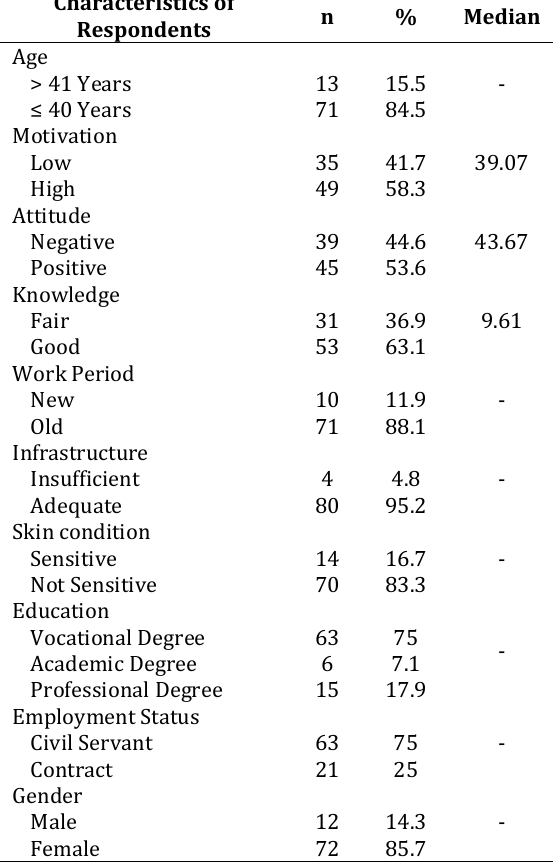
Table 1. Characteristics of Research Respondents Characteristics of